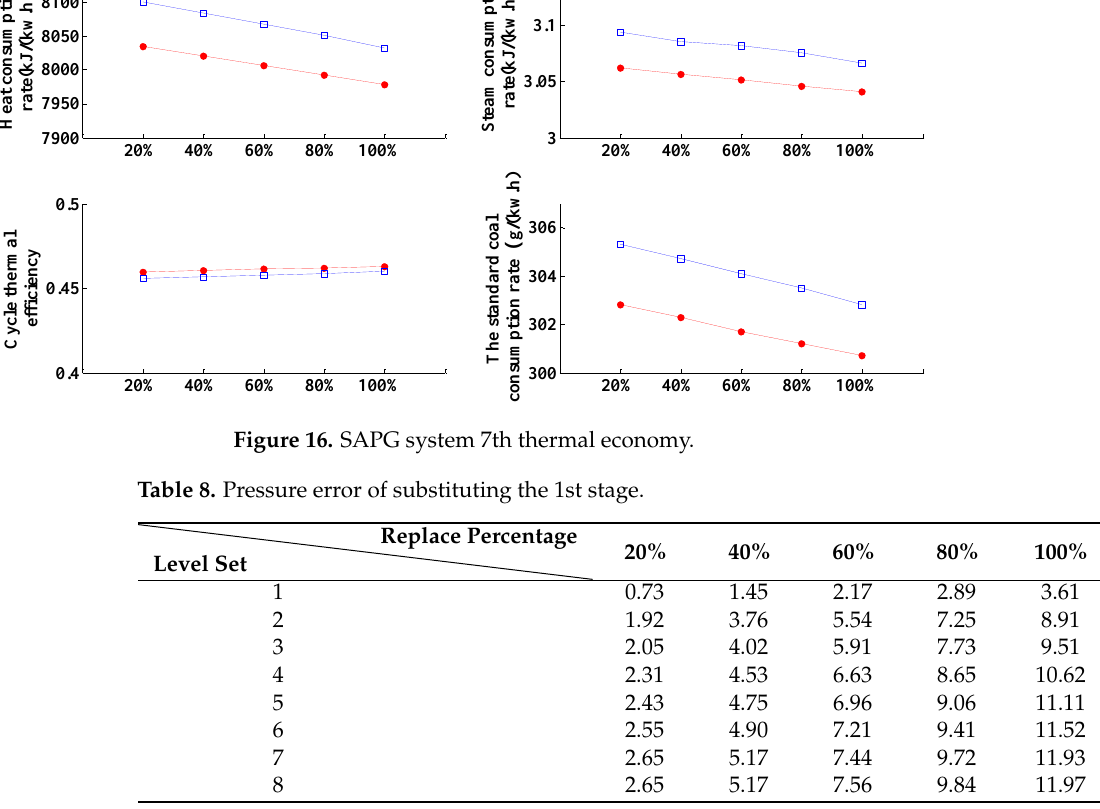
19 of 25 Figure 14. SAPG system 5th thermal economy.